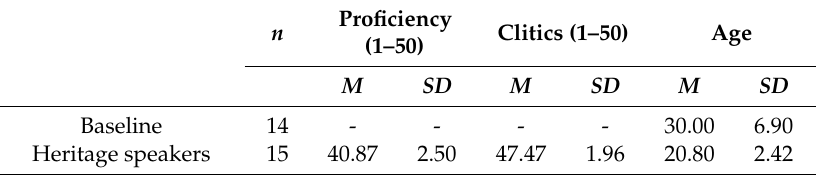
Table 3. Participants’ mean written proficiency score, mean clitics score, and mean age for the baseline and heritage speaker